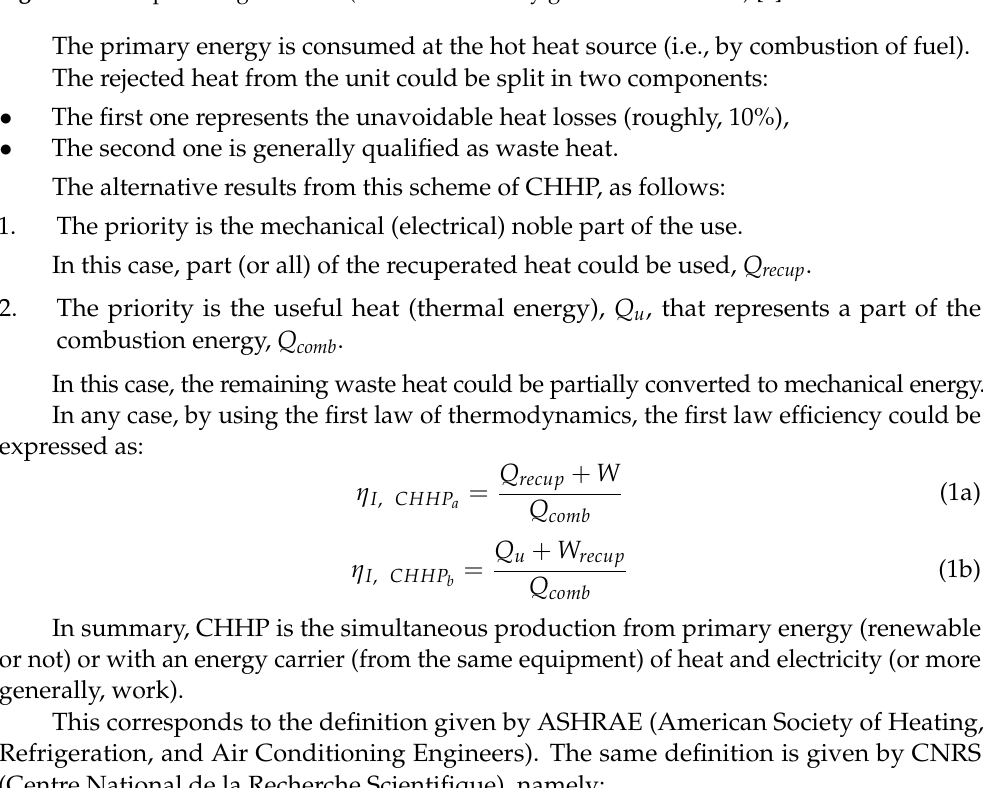
Figure 1. Principle of cogeneration (the values are only given as indicatives) [2].